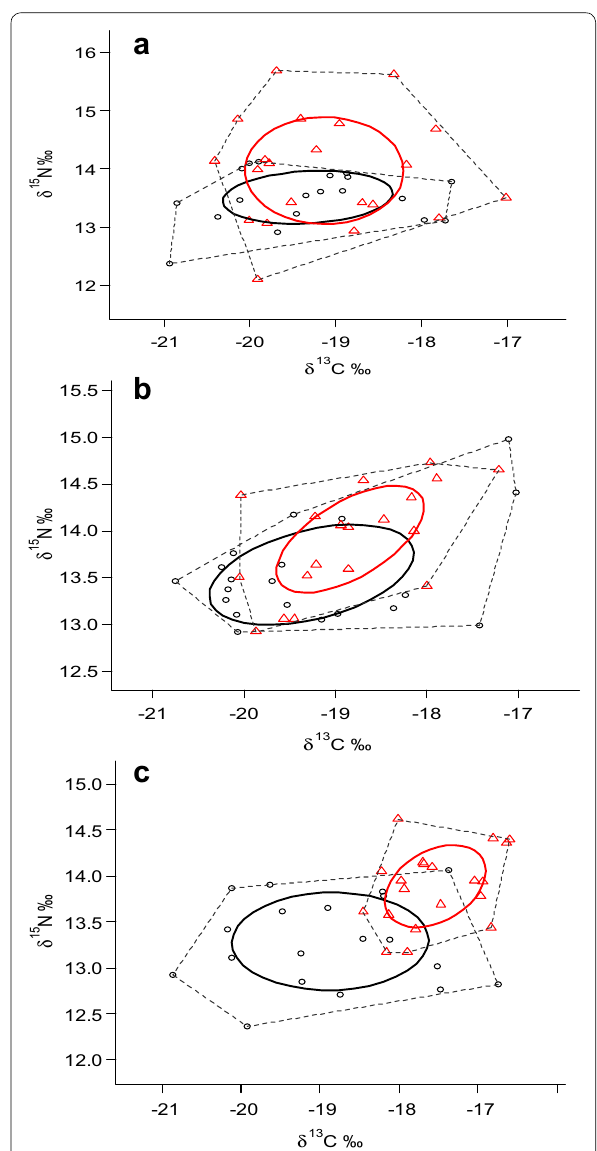
Fig. 3 Standard ellipse areas (‰) and convex hulls of the predatory fish species in the Pangani estuarine zones. Standard ellipse areas (‰) are corrected for small sample sizes denoted as SEAc in solid line cycles that comprised about 40% of isotopic data, presented as ○ (open points) for Carangoides chrysophrys and ∆ open (triangle points) for Epinephelus malabaricus . Convex hull areas (TA) presented as dotted lines indicate the total niche space occupied by each species, The letters, a , b and c indicate upper, middle and